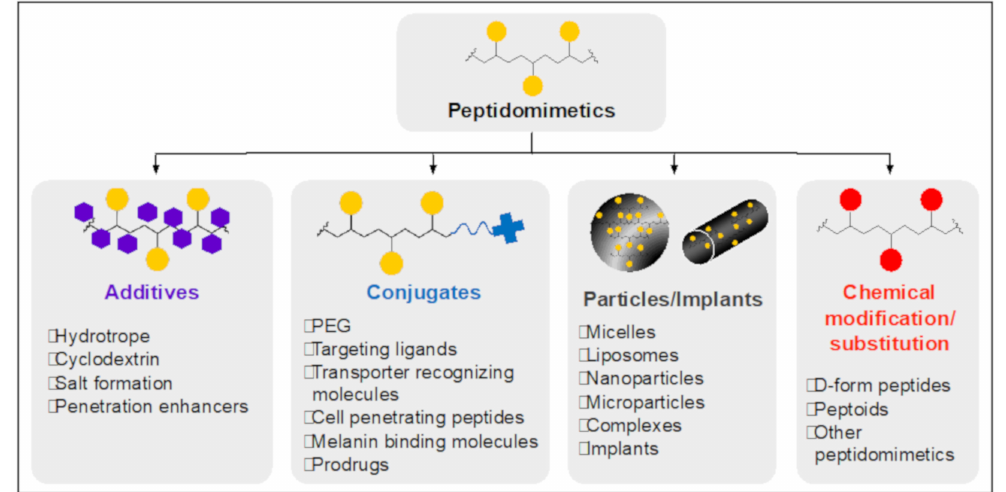
Figure 7. Various formulation strategies of peptidomimetic ocular drugs. For retinal delivery, drugs can be co-administered with additives or formulated by conjugation with functional moieties, encapsulation into particles or implants, and direct chemical modifications/substitutions. Red circle indicates the further modifications in backbone moieties of